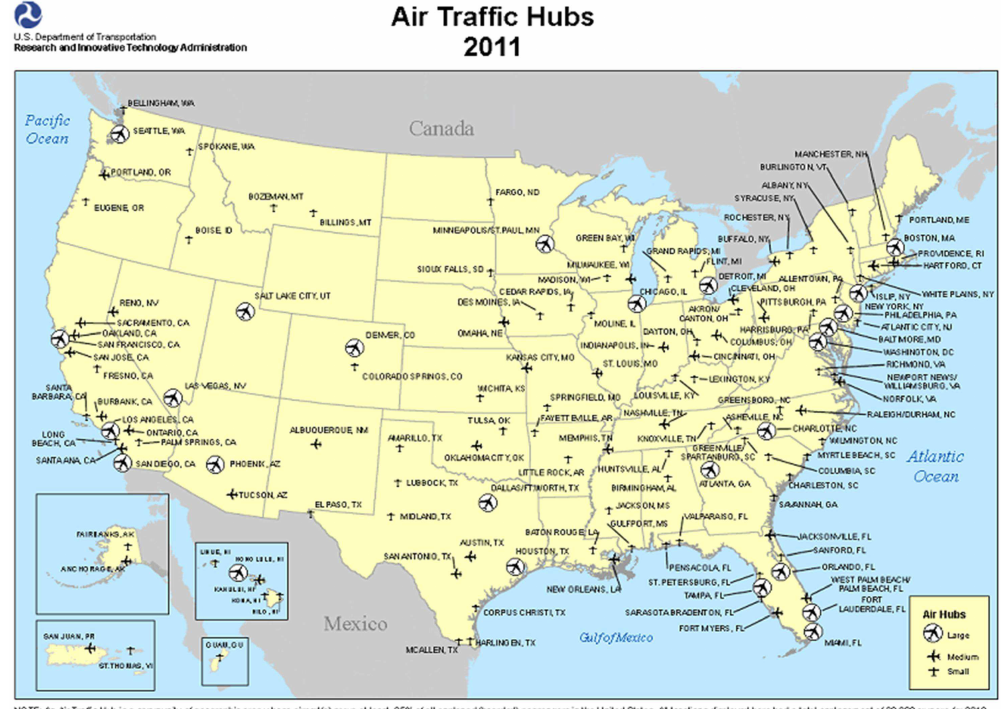
Fig. 11. Air Traffic Hubs in the US.